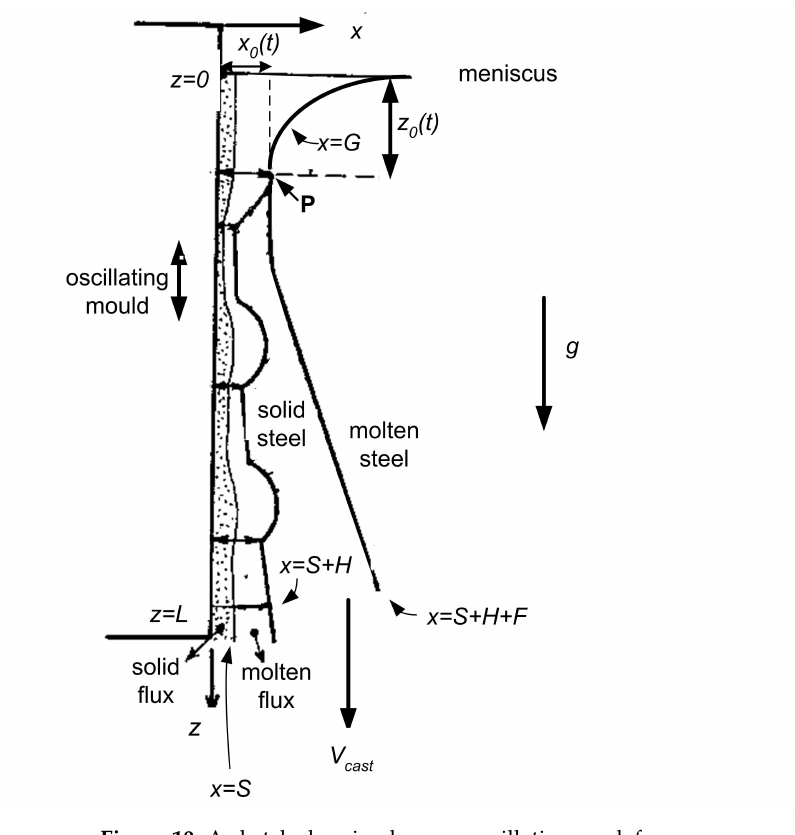
Figure 10. A sketch showing how an oscillation mark forms.